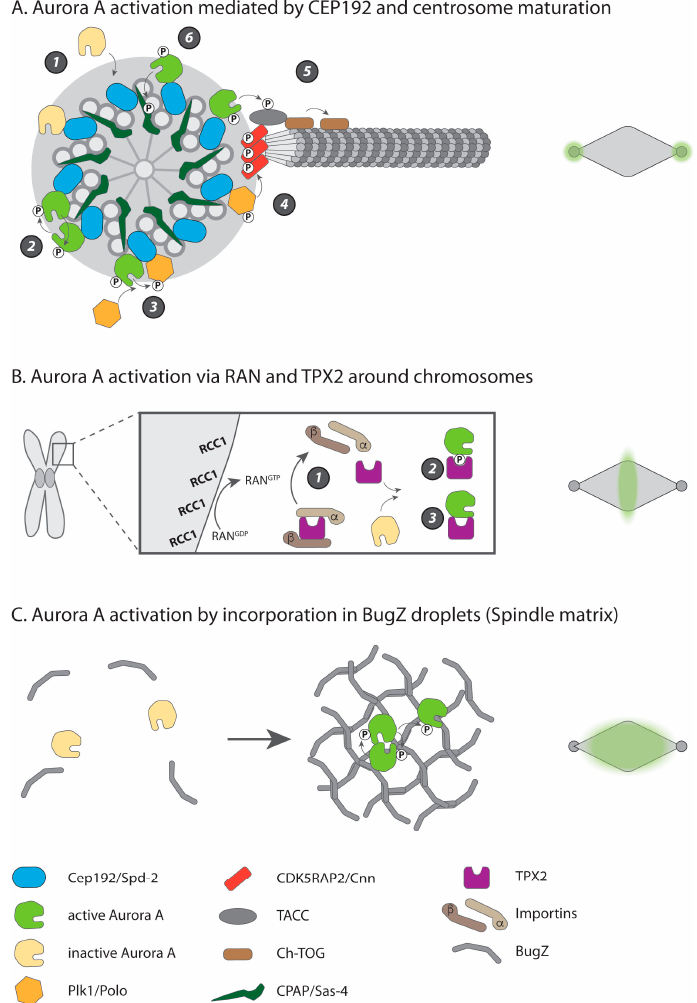
Figure 2. Aurora A activation at the centrosome and the mitotic spindle. ( A ) Model for Aurora A activation and subsequent centrosome maturation based on the literature in different model systems. During mitotic entry, (1) inactive Aurora A is recruited on the centrosome by the Centrosomal Protein 192 (Cep192 or Spd-2 in Drosophila and Caenorhabditis elegans ). (2) This recruitment favours dimerization, trans-autophosphorylation and activation. (3) Polo-like kinase 1 (Plk1) is subsequently phosphorylated by Aurora A and docked on Cep192. (4) Active Plk1 phosphorylates Cyclin-Dependent Kinase 5 Regulatory subunit-Associated Protein 2 (CDK5RAP2) (Cnn in Drosophila ) that undergoes multimerization. CDK5RAP2 displays a binding site for γ -tubulin ring complex ( γ TuRC), consequently strong microtubule (MT) nucleation is induced at the centrosome surface. CDK5RAP2 also display a binding site for the Transforming Acidic Coiled-Coil containing Protein 1/Colonic and hepatic Tumour Overexpressed Gene protein (TACC/Ch-TOG) complex. (5) Phosphorylation of TACC by Aurora A triggers recruitment of the TACC/Ch-TOG complex on the centrosome. Ch-TOG stimulates astral MT growth. (6) Aurora A also phosphorylates Centrosomal P4.1 Associated Protein (CPAP), to maintain centrosome architecture. ( B ) Activation of Aurora A around chromosomes by Targeting Protein for Xklp2 (TPX2). (1) The RAs-related Nuclear Guanine Exchange Factor (RAN-GEF) RCC1 is anchored on mitotic chromatin and triggers the formation of a RAN GTP gradient around chromosomes. RAN GTP triggers the release of TPX2 from importins α and β . (2) TPX2 can protect active auto phosphorylated Aurora A from dephosphorylation. (3) TPX2 can bind to and activates Aurora A kinase, without auto phosphorylation. ( C ) Activation of Aurora A by incorporation into droplets. Aurora A can be incorporated into Bub3 interacting and GLEBS motif containing ZNF207 (BugZ) coacervates/droplets (that also contain spindle matrix proteins), to trigger Aurora A dimerization and auto phosphorylation. The right part of the picture shows the location of each Aurora A activated pool (light